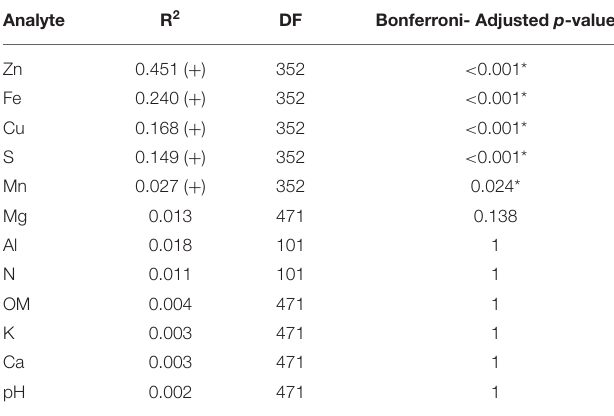
TABLE 2 | Relationship between soil test phosphorus (STP) and soil chemistry data averaged across the selected 52 elevated-P fields from interested farmers.